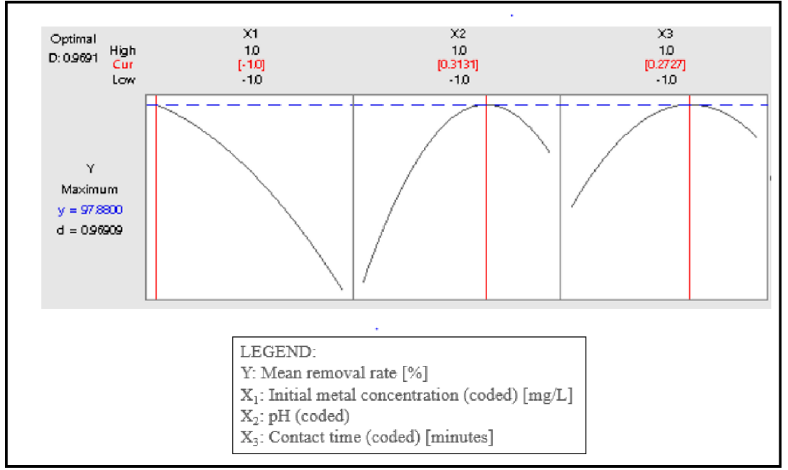
Figure 7. Response optimization results in the removal of cadmium with different contact times, pH, and initial metal concentrations.